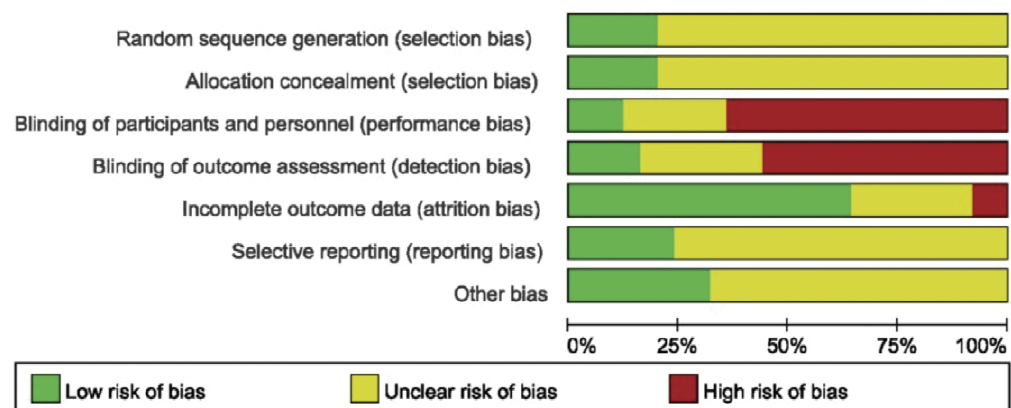
Figure 2. Risk of bias graph available according to recommendations from the Cochrane Collaboration. doi:10.1371/journal.pone.0043655.g002 PLOS ONE |